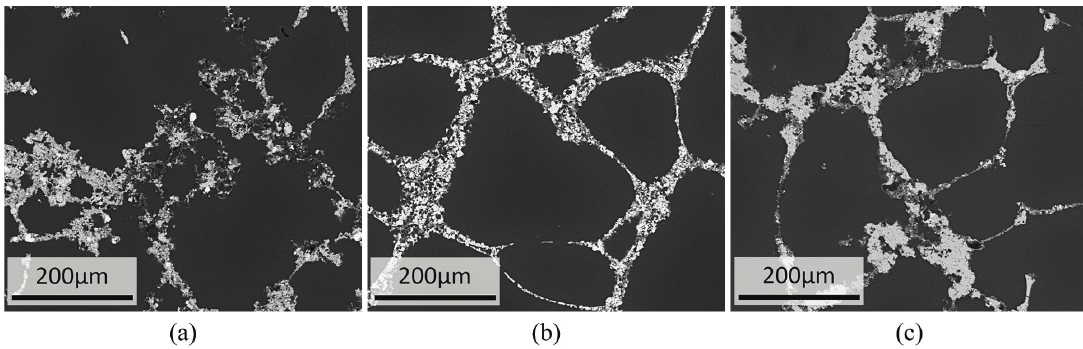
Figure 2. BSE images of the investigated ZK60-RE alloys submitted to solution heat treatment for 8h at 500 °C: (a) ZK60-0.5 wt.%RE, (b) ZK60-1.5 wt.%RE and (c) ZK60-2.5 wt.%RE.